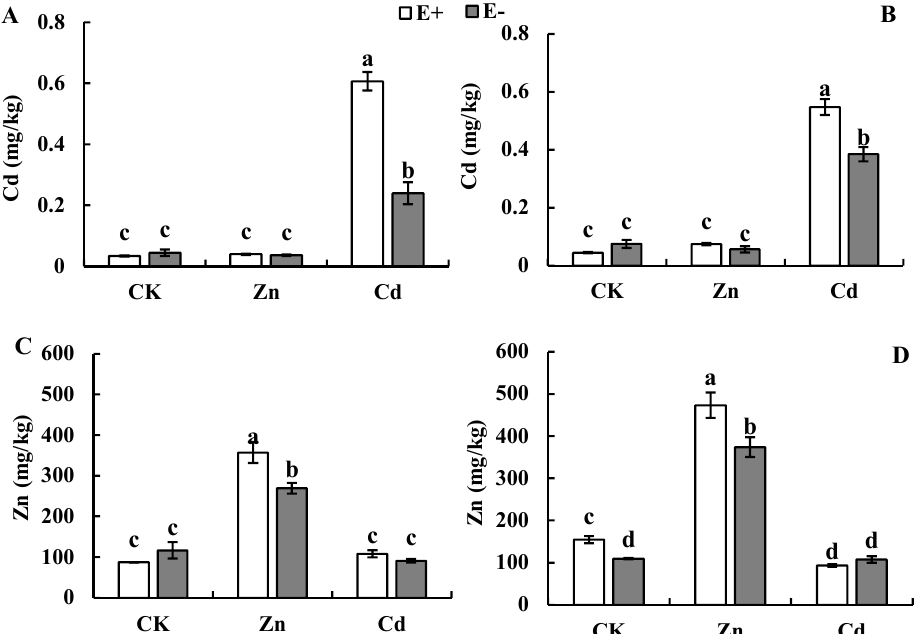
Figure 4. Effect of Epichloë endophyte and Cd 2+ and Zn 2+ treatments on the aboveground and underground concentration of Cd 2+ and Zn 2+ ions in F. sinensis ; ( A ): aboveground Cd 2+ ions, ( B ): underground Cd 2+ ions, ( C ): aboveground Zn 2+ ions, ( D ): underground Zn 2+ ions. Note: Different lowercase letters indicate significant differences between treatments ( p < 0.05).